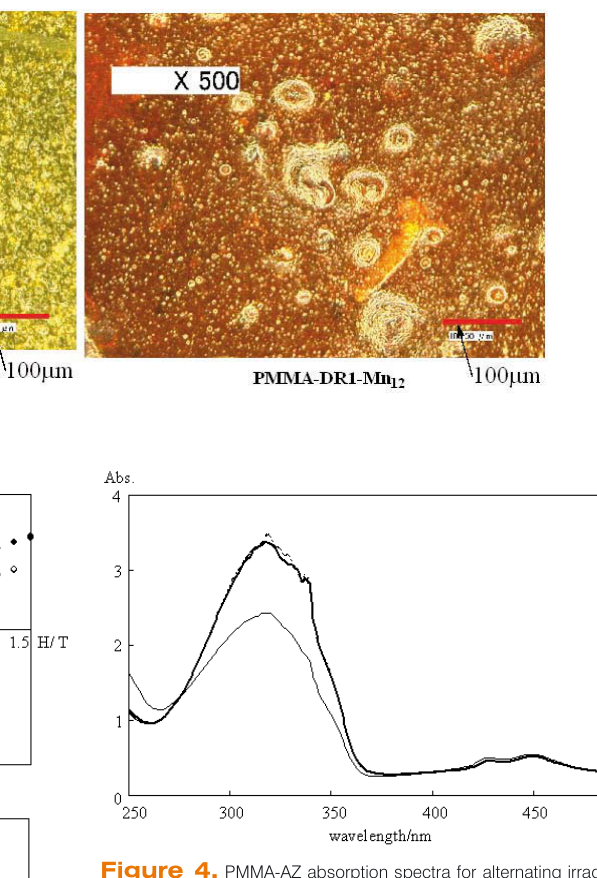
Figure 4. PMMA-AZ absorption spectra for alternating irradiations with polarized light at 298 K for 3 min (dotted line for initial, thin line for UV after 20 cycles, and bold line for visible after 20 cycles).